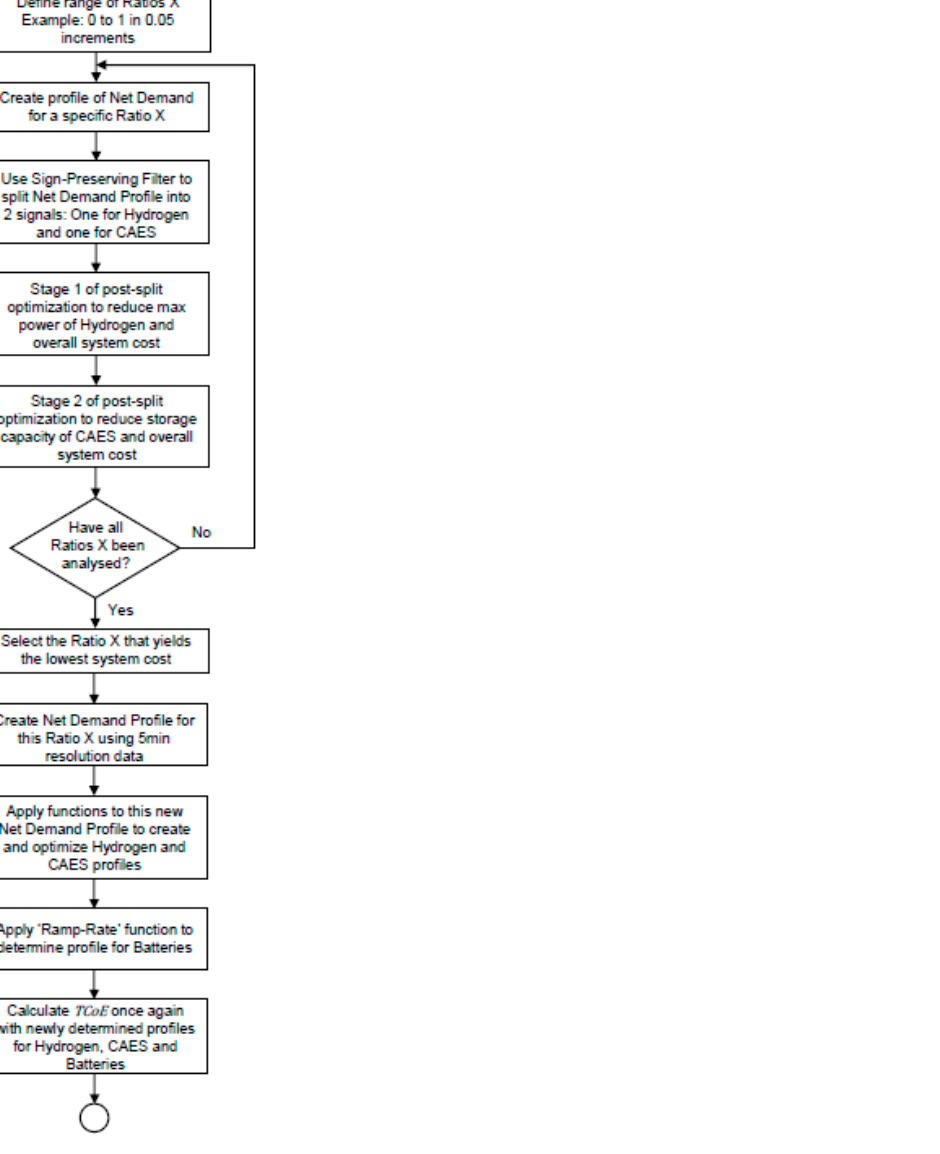
Figure 4. General algorithm followed to determine optimum split of storage duty between different storage technologies.